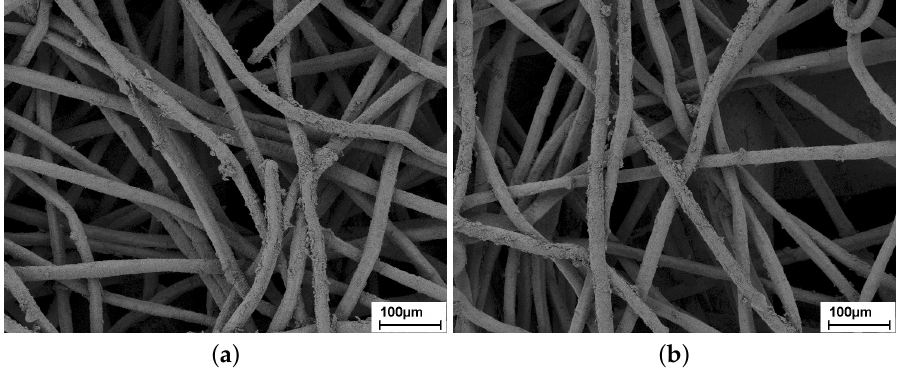
Figure 3. SEM images of sintered fiber felts after 12 months of fouling. ( a ) SFF 100; ( b ) SFF 150.